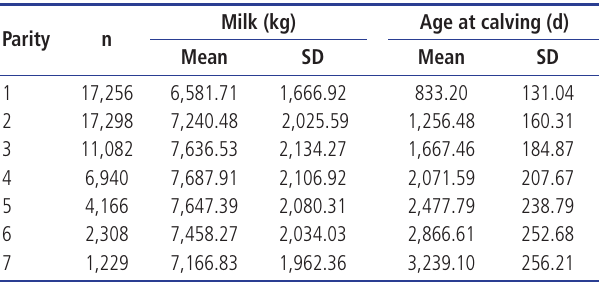
Table 1. Simple statistics of the